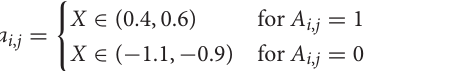
δ ij initially. The 10, γ 20, ρ 0, σ 10 − 6 with a i , j = = = = = −